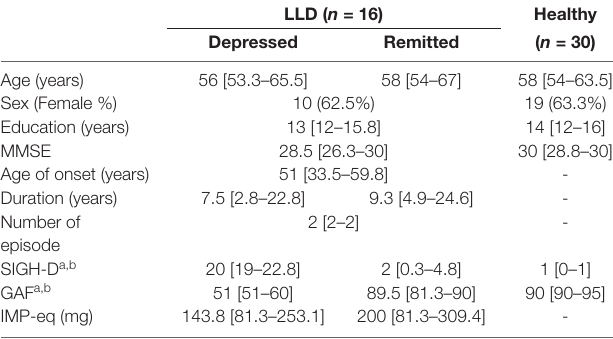
Data represent median [inter-quartile range]. LLD, later-life depression; MMSE, Mini-mental state examination; SIGH-D, Structured Interview Guide for the Hamilton Rating for Depression Scale; GAF, Global Assessment of Functioning; IMP-eq., Imipramine equivalent. a Depressed vs. Remitted; p < 0.05 by Wilcoxon signed ranks test. b Depressed vs. Healthy; p < 0.05 by Mann-Whitney U